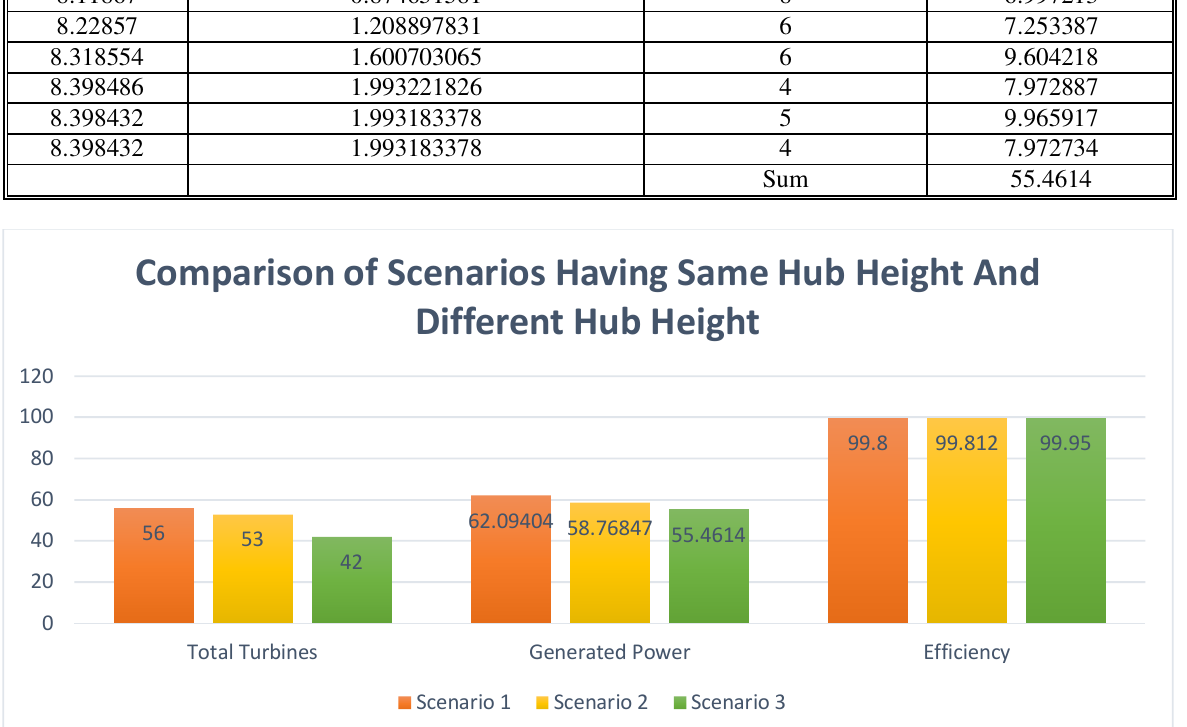
Fig. 11: Comparison of output and efficiency of three scenarios Wind input without losses due to velocity deficit, turbines in each row and power output generated by power output of single wind turbine of each row, total each row in the continuous spaced wind farm